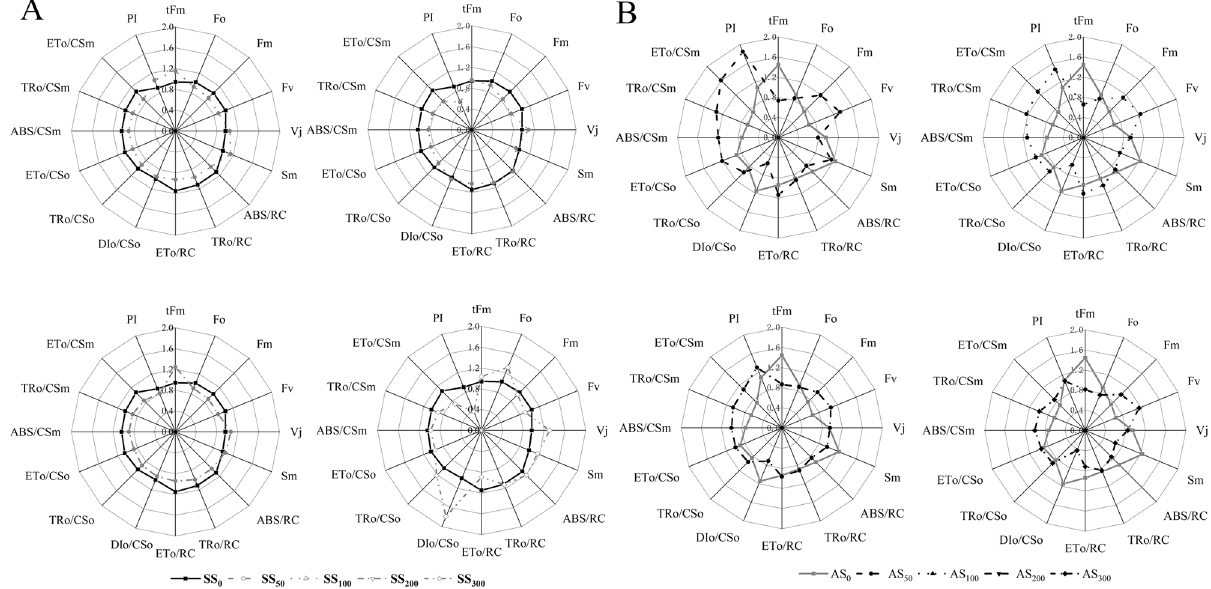
Figure 4. Effects of ( A ) salt stress and ( B ) alkali stress on the parameters associated with the chlorophyll fluorescence of Goji berry after 20 days of treatment with different salt solutions. Values are represented as the mean ± SE (n = 5).